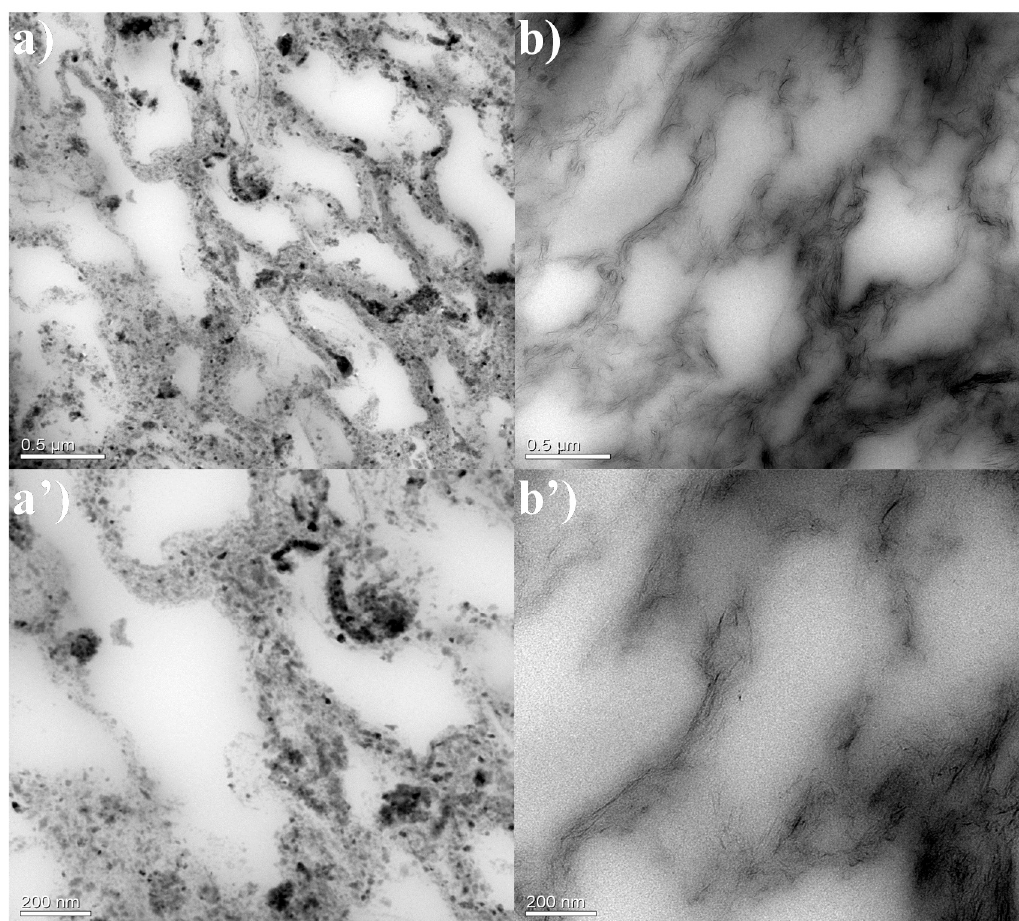
Figure 1. TEM images of MGNR-6 ( a , a’ ) and GNR-6 composites ( b , b’ ).